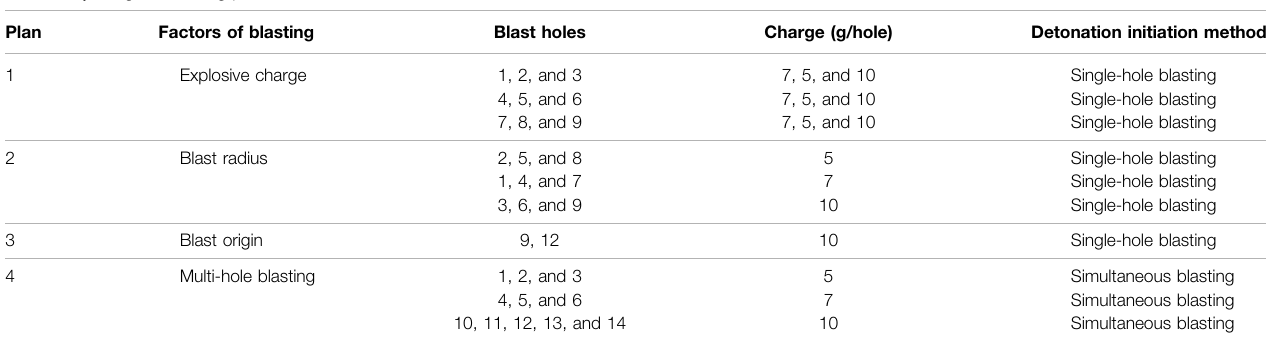
TABLE 4 | Design of blasting plans.